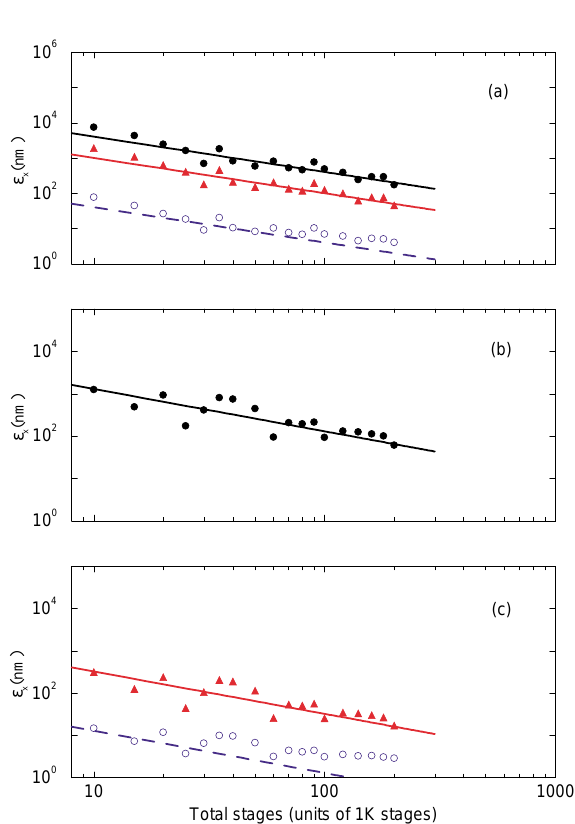
FIG. 2. (Color) Emittance degradation as a function of the total number of stages for two types of gap widths and different jitter parameters: s D (cid:1) 1 m m (solid circles), 0.5 m m (triangles), and 0.1 m m (open circles). Lines are fits to data points based on a stochastic theory in zero-correlation length approximation. The solid lines are for s D (cid:1) 1 m m and 0.5 m m, and the dashed lines are for s D (cid:1) 0.1 m m. (a) gap (cid:1) 10 tubes, (b),(c) gap (cid:1)